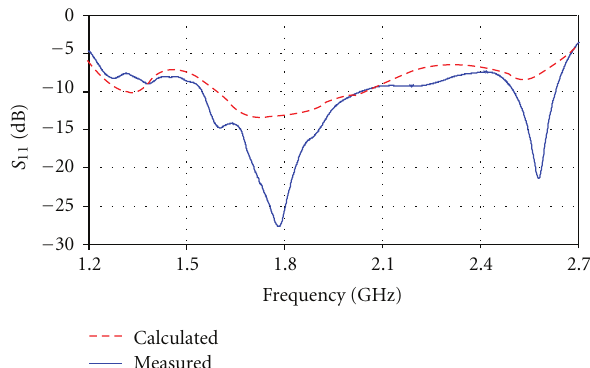
Figure 3: Calculated and measured return loss of the high-band antenna of the first dual antenna